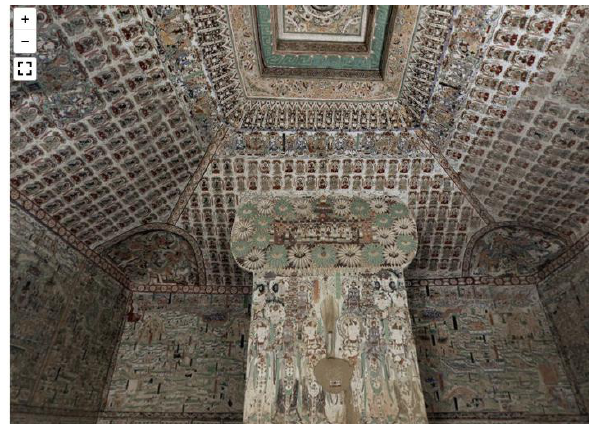
Figure 9. Cave Panorama